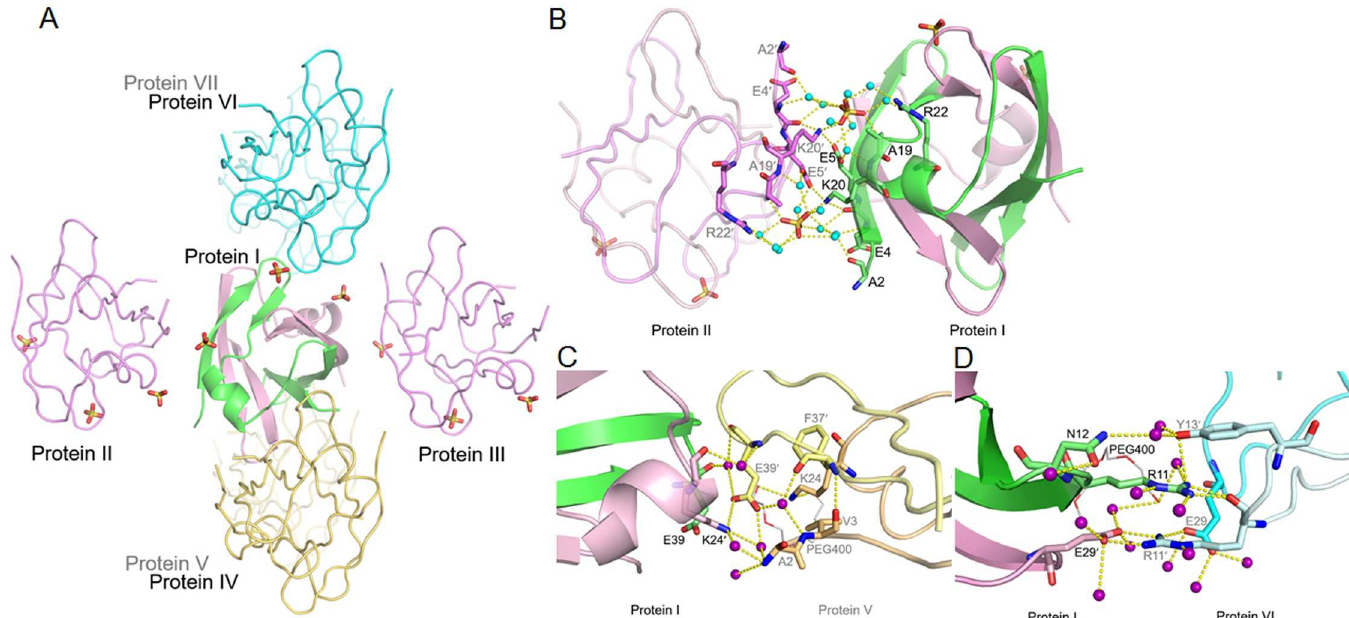
Fig 2. Protein-protein interactions in the wild-type Sso7c4 crystal. (A) One Sso7c4 protein interacts with six neighboring proteinsthrough three patterns. Protein I is depictedas a ribbonand the six symmetry-related proteins are drawn as coils. (B) Detailedview of the sulfate-mediated interactionsat the protein interface. (C) Detailedview of the electrostatic interactions betweenside chains of K24 0 and E39 0 at the protein interface. (D) Detailedview of the hydrogen bond arrays aroundthe R11 (R11 0 ) and E29 (E29 0 ) side chains betweenproteinsI and VI. All water moleculesare displayedas cyan spheres in panel B and as purplespheresin panels C and D. The hydrogenbondsare shown as yellow dashed lines in all